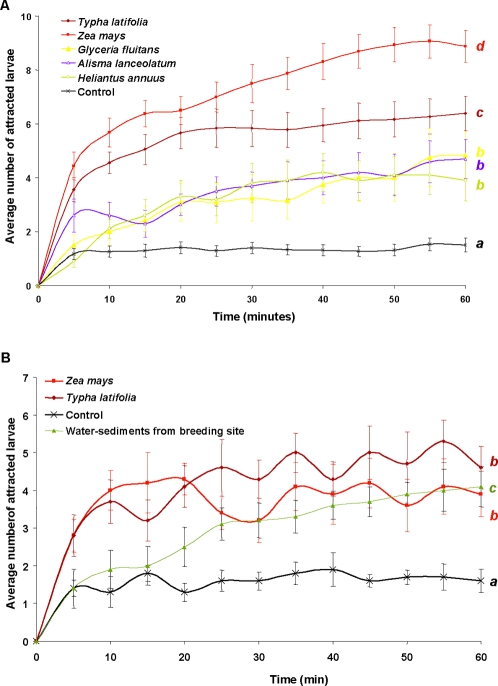
Responses of Coquillettidia larvae to different plant exudates.1A, attractiveness measured with host and non-host plants. Roots of plants were put in 4-channel-olfactometer with a water flow rate of 3.2 ml/min. 1B, attractiveness to the root exudates solution of host plants (Maize and Typha). Responses are expressed in Average (±SE) number of attracted larvae in function of time, under red light. ANOVA, p<0.0001, Superscriptsa,b,c,d indicate differences at a significant level of 0.05.